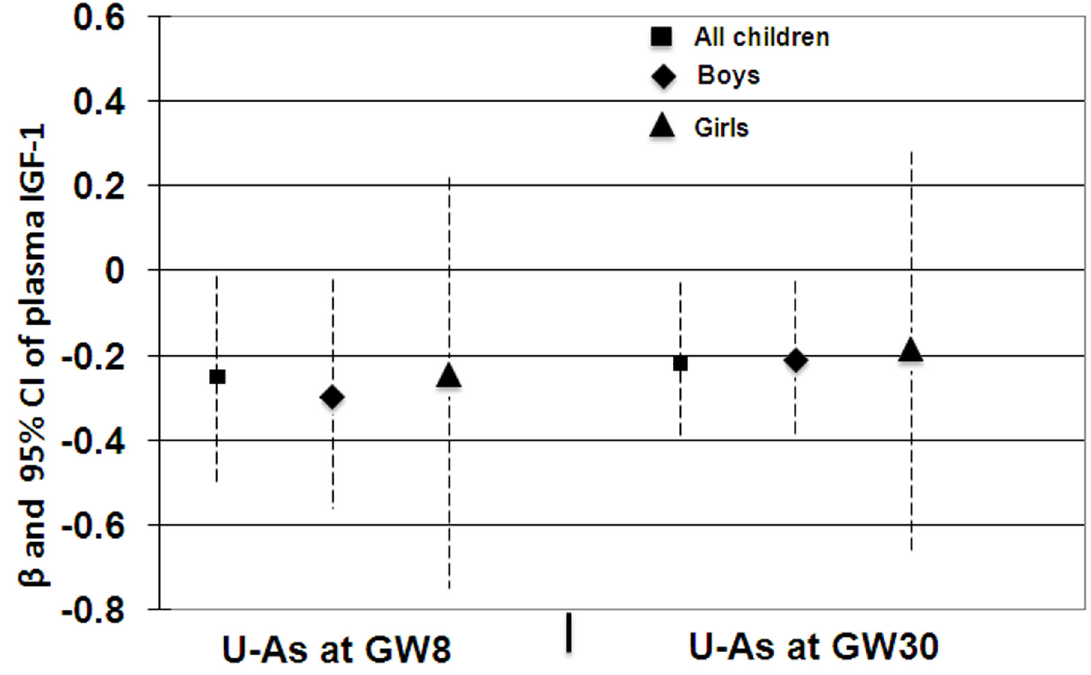
Figure 3. Associations between maternal urinary arsenic at gestational week (GW) 8 and 30 with cord blood insulin-like growth factor 1 (IGF-1) in all children, boys and girls. The associations were adjusted with mother age, socioeconomic status (SES), parity (birth order), child sex (for all children), and birth weight and height.